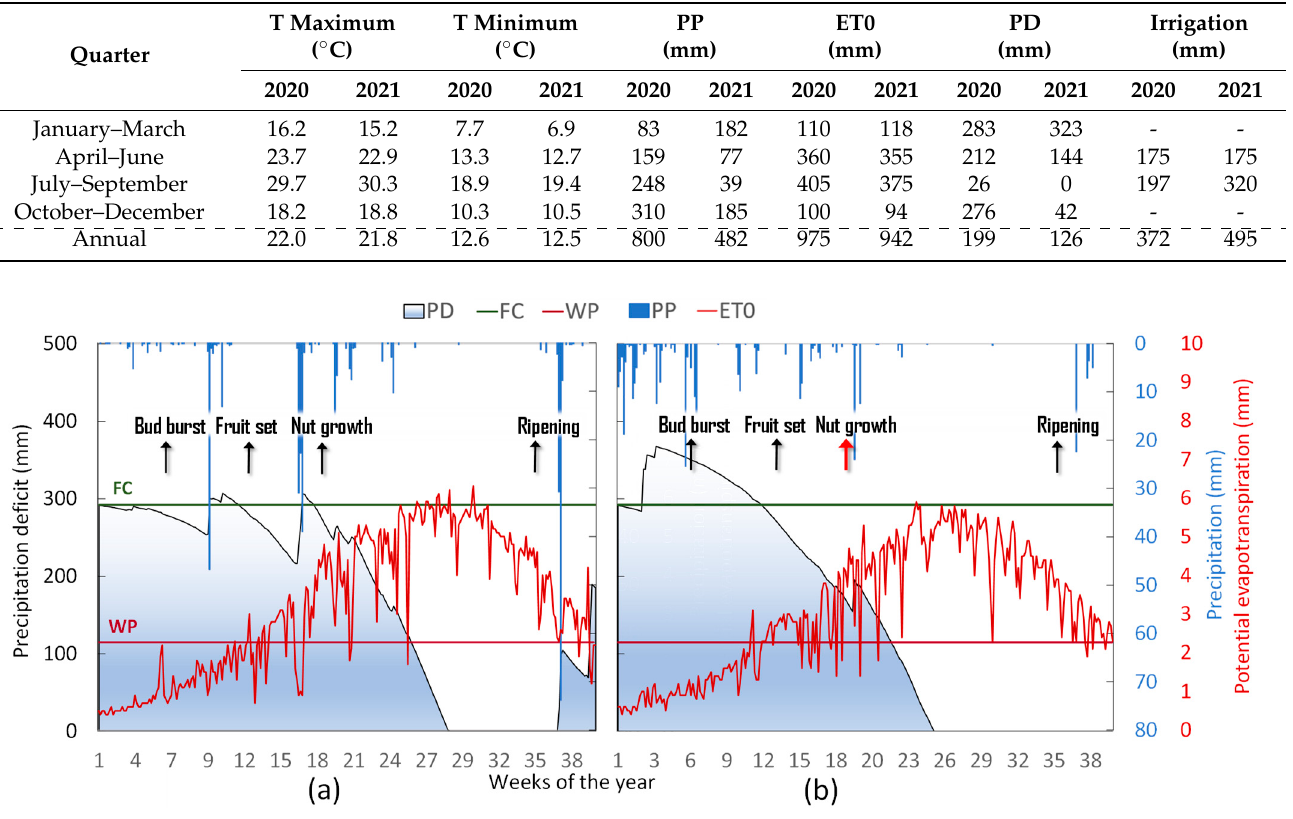
Figure 2. Patterns of precipitation deficit (PD), field capacity (FC), wilting point (WP), precipitation (PP), and potential evapotranspiration (ETo) during the growing seasons 2020 ( a ) and 2021 ( b ), from